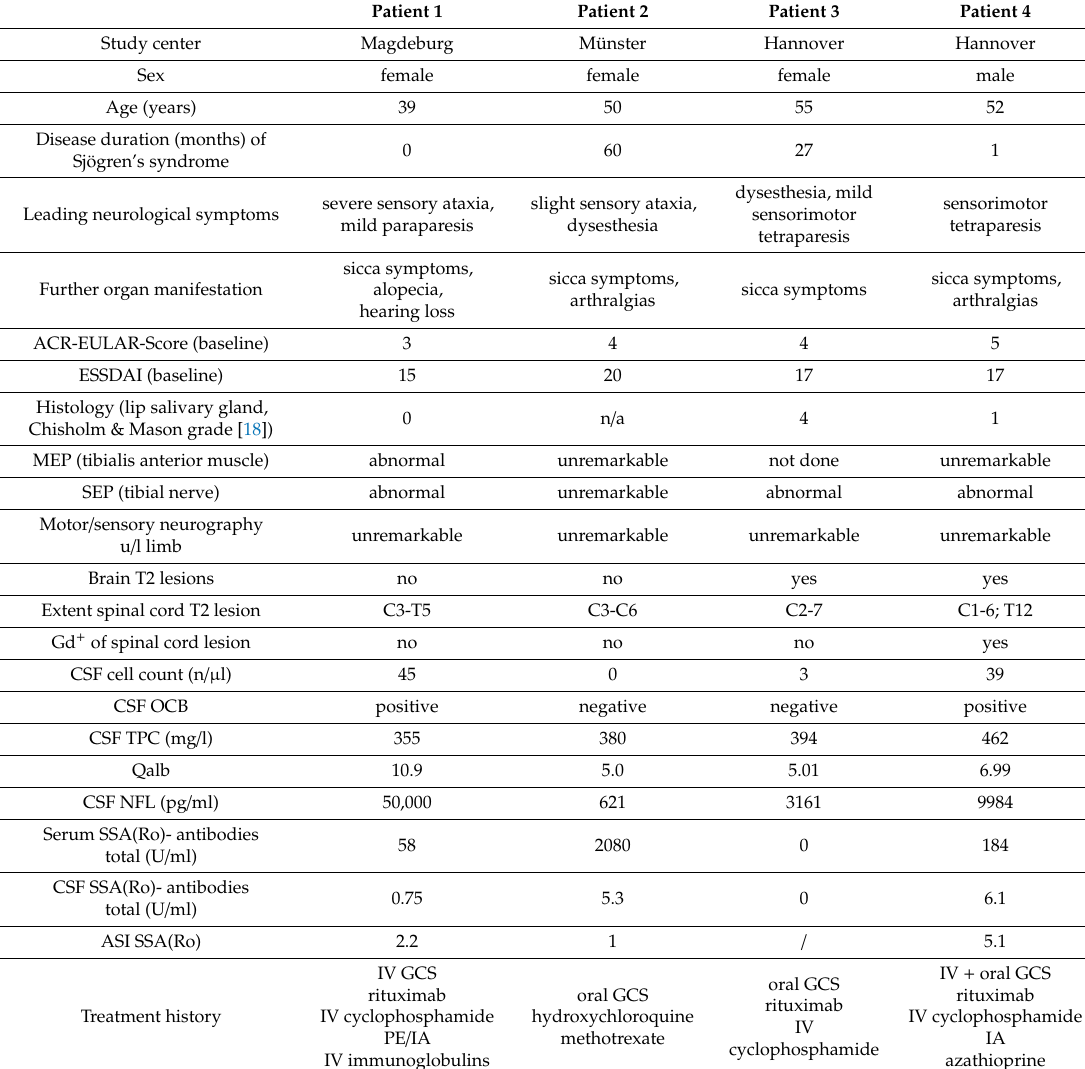
Table 1. Clinical, radiological, and laboratory